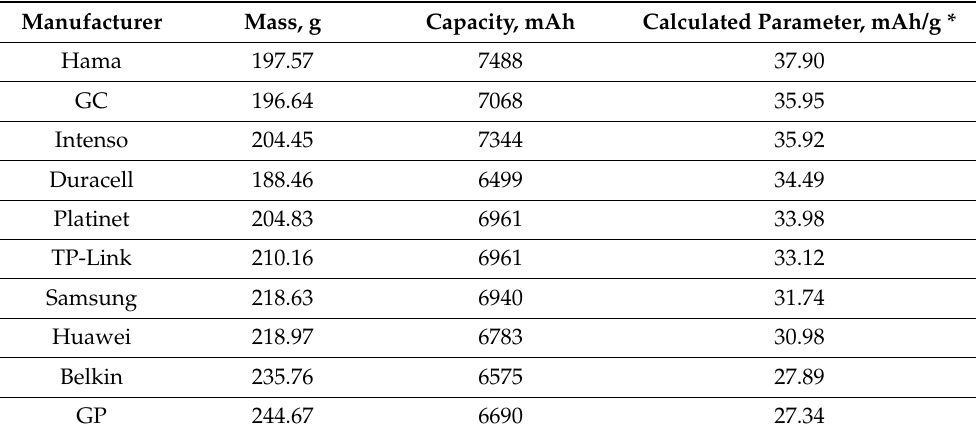
Table 6. Comparison of masses and calculated values of the parameter describing the relationship between the capacity of a power bank and its weight.